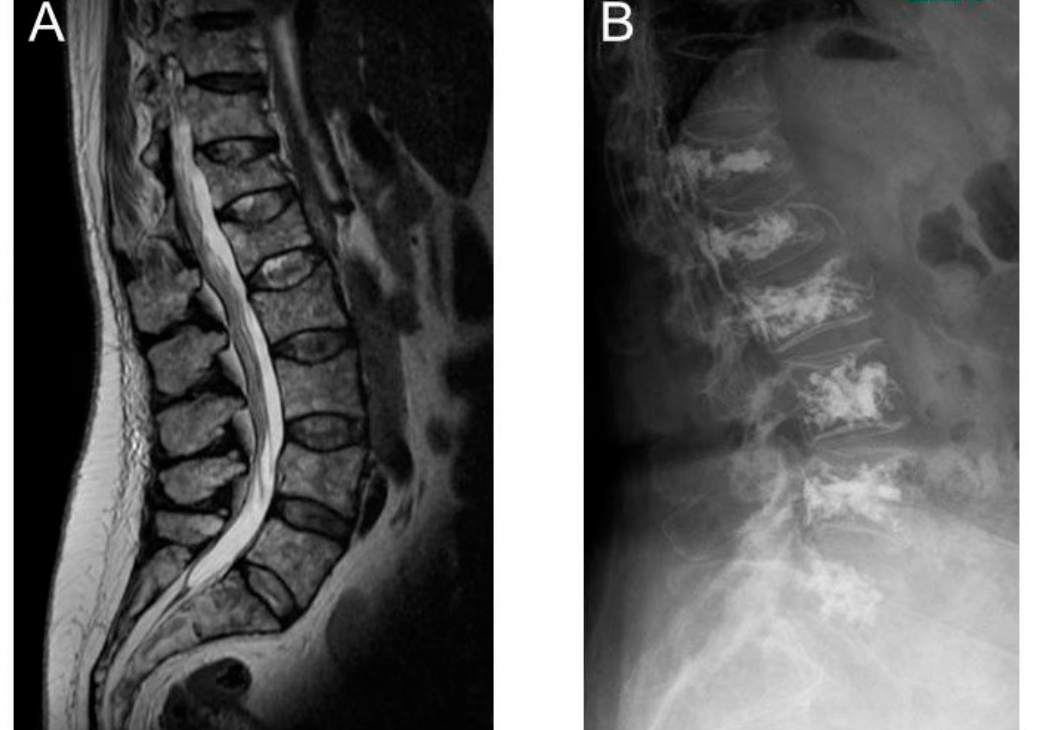
Figure 5. ( A ) MRI scan of multiple myeloma patient with several lesions of lumbar vertebrae and Th12. ( B ) Post-operative X-ray of the same patient after vertebroplasty in Th12 to L5 vertebrae. Bone cement leakage is visible related to L1.